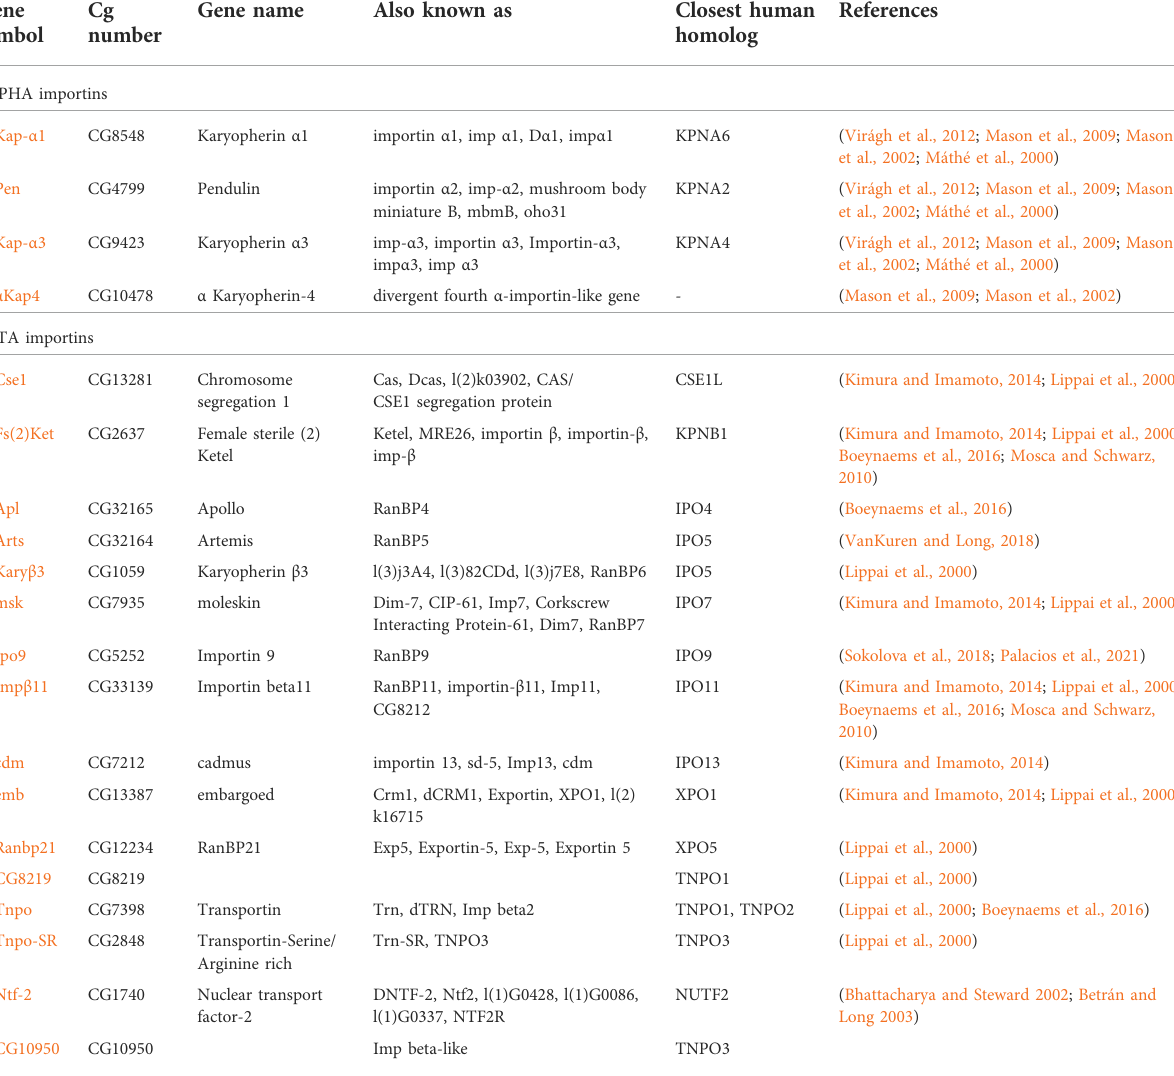
TABLE1Importinsof Drosophilamelanogaster .References: [1]Virághetal.,2012;[2]Masonetal.,2009;[3]Masonetal.,2002;[4] Máthé etal.,2000; [5]Kimuraand Imamoto, 2014; [6]Lippai etal., 2000;[7] Boeynaems etal.,2016;[8]Mosca andSchwarz,2010;[9] VanKuren and Long, 2018;[10] Sokolova et al., 2018; [11] Palacios et al., 2021; [12] Bhattacharya and Steward 2002; [13] Betrán and Long